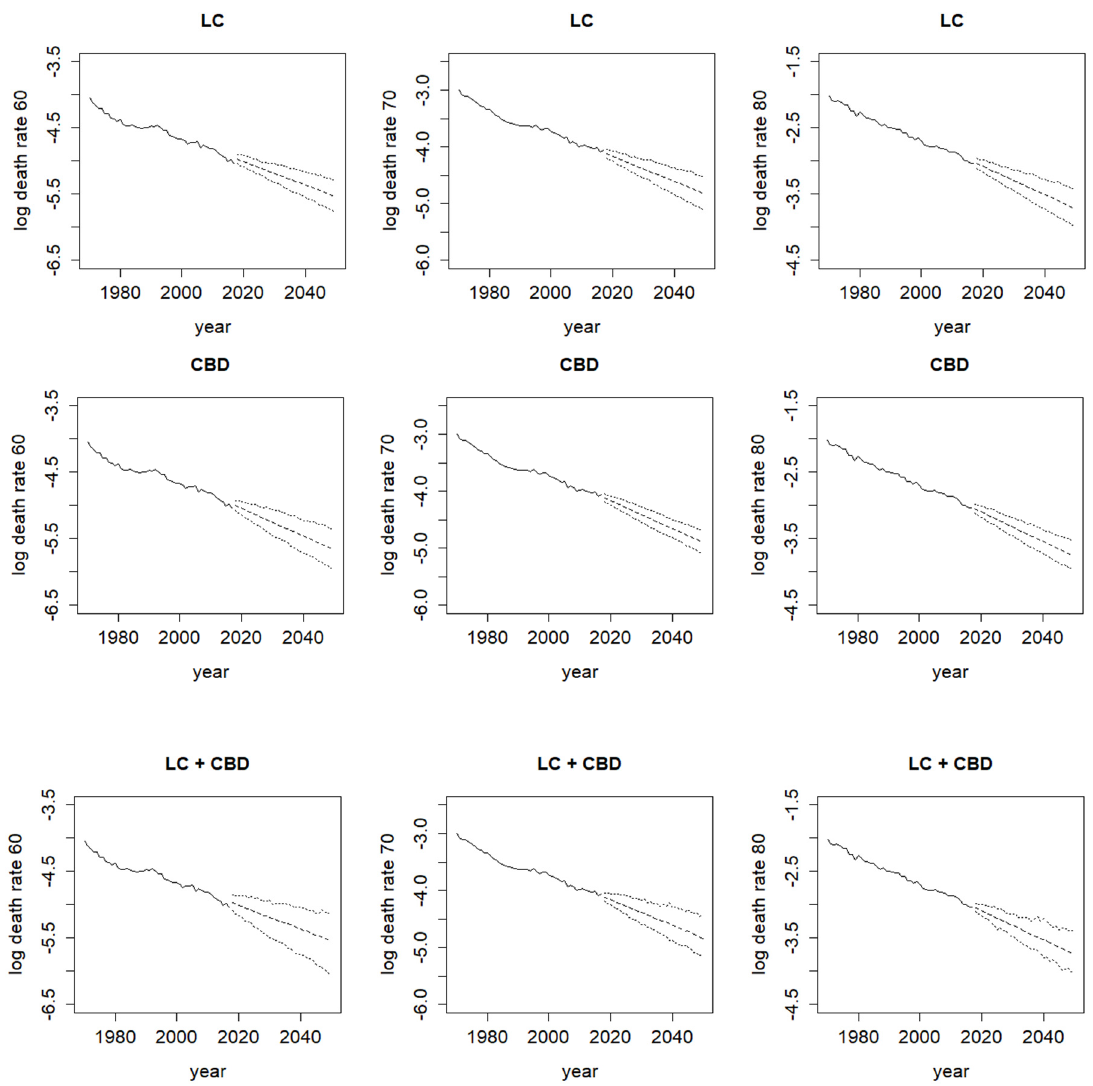
Figure 4. Log death rates at ages 60, 70, and 80 from 1970 to 2050 (solid—observed values; dashed—projected values; dotted—95% prediction intervals) under Bayesian Lee–Carter model (alone), CBD model (alone), and mixture model.